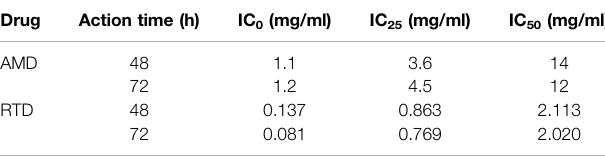
TABLE 2 | IC 0 , IC 25 , and IC 50 of AMD and RTD in each action time.